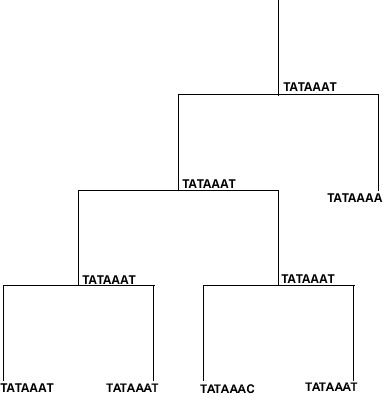
A similar reconstruction of ancestral promoter sequences is shown, using a standard method. Changes along branches in Figure 3 can then be compared with changes along the same branch in Figure 4.